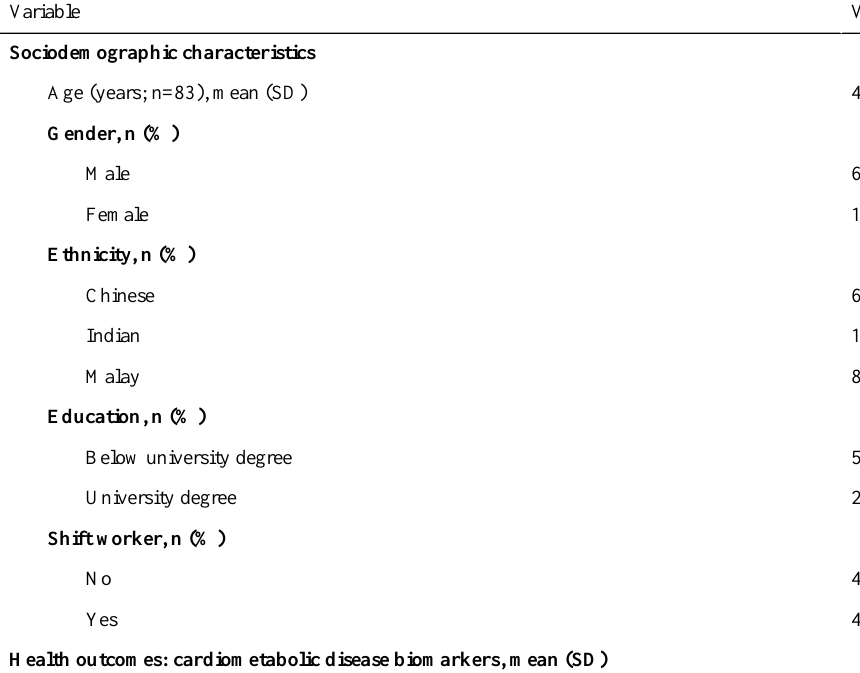
Table 2. Summary statistics of